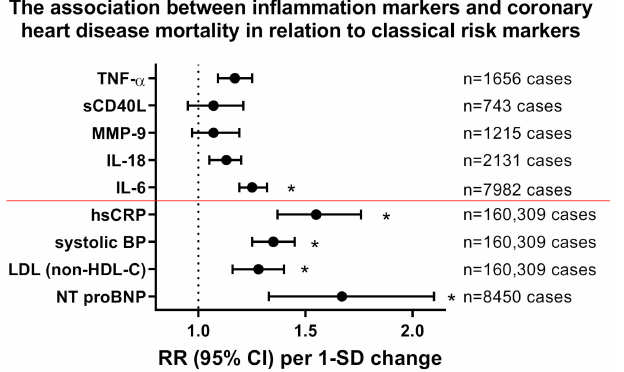
Impact of inflammation markers on cardiovascular mortality and comparison to classical / established cardiovascular risk markers. Relative risk (RR) for all coronary heart disease mortality in correlation with markers of inflammation interleukin (IL)-6, IL-18, matrix metalloproteinase (MMP)-9, soluble CD40 ligand (sCD40L or CD154) and tumor necrosis factor (TNF)- α obtained by meta-analysis with adjustment for age, sex, smoking status, adiposity markers, blood pressure and / or lipid markers (number of cases as indicated). Inflammatory risk markers were compared to classical cardiovascular risk markers such as hsCRP, systolic blood pressure (BP), low density lipoprotein (LDL, measured as non-HDL-C) and N-terminal fragment of natriuretic peptide type B (NT proBNP). The classical risk markers are all below the red line. Risk increases are shown per 1-SD changes of cytokines and classical cardiovascular risk markers. * indicates significant di ff erences to control group. Redrawn from tabular data in [14] for inflammation markers, [17,18] for hsCRP / systolic BP / LDL (measured as non-HDL-C) and [19] for NT